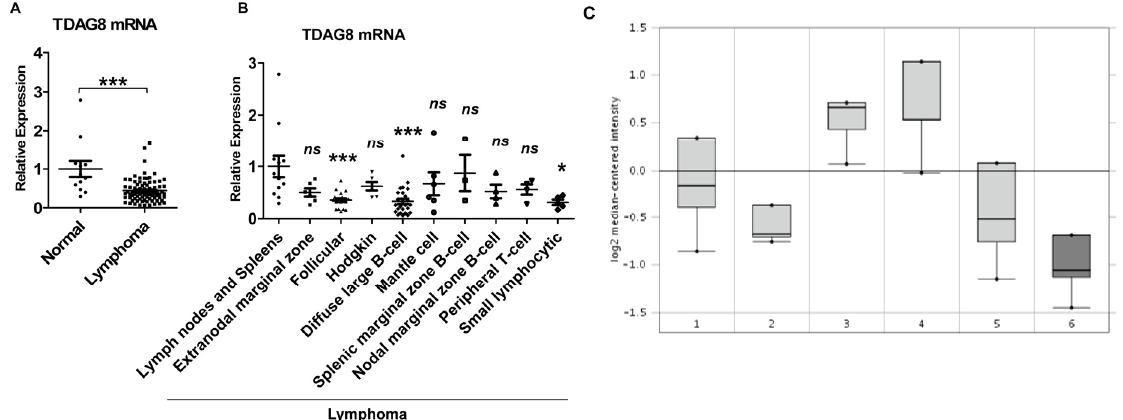
Figure 6. TDAG8 expression is lower in lymphomas than that in normal lymphoid tissues. ( A , B ) Human lymphoma tissue cDNA arrays (OriGene Technologies) were subject to real-time RT-PCR using TDAG8 specific primer probes. β -actin was used as an internal control for normalization. TDAG8 expression was compared between non-tumorous lymphoid tissues (lymph nodes and spleens) and all tested lymphoma tissues ( A ) or different subtypes of lymphoma tissues ( B ). The expression of TDAG8 in lymph nodes and spleens was set as one. Each dot represents an individual sample. Error bars indicate ±SEM. * p < 0.05; *** p < 0.001; ns, not significant ( p > 0.05); ( C ) Analyses of the Oncomine cancer microarray database revealed that TDAG8 expression was reduced by two-fold in follicular lymphoma in comparison to normal lymphocytes ( p < 0.001). x -axis: 1, B-lymphocyte; 2, centroblast; 3, memory B-lymphocyte; 4, naive pregerminal center B-lymphocyte; 5, small cleaved follicle center cell; 6, follicular lymphoma. median-centered y -axis: log 2